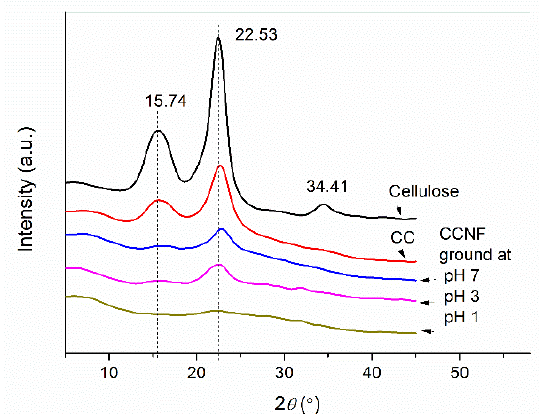
Figure 5. XRD patterns of eucalyptus lignocellulose, CC (DS = 0.123), and CCNF samples ground at different pH values.